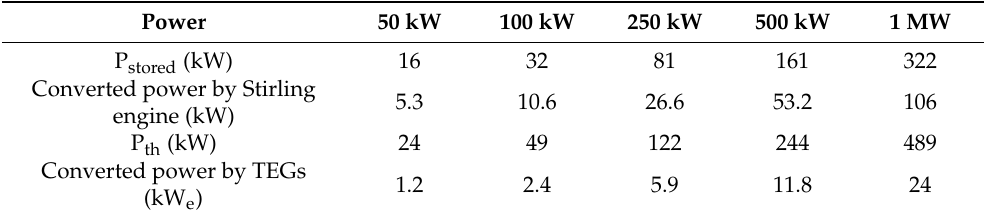
Table A6. Calculation of the P stored as a function of the CSP plant size, together with the converted power by the Stirling engine and the TEG